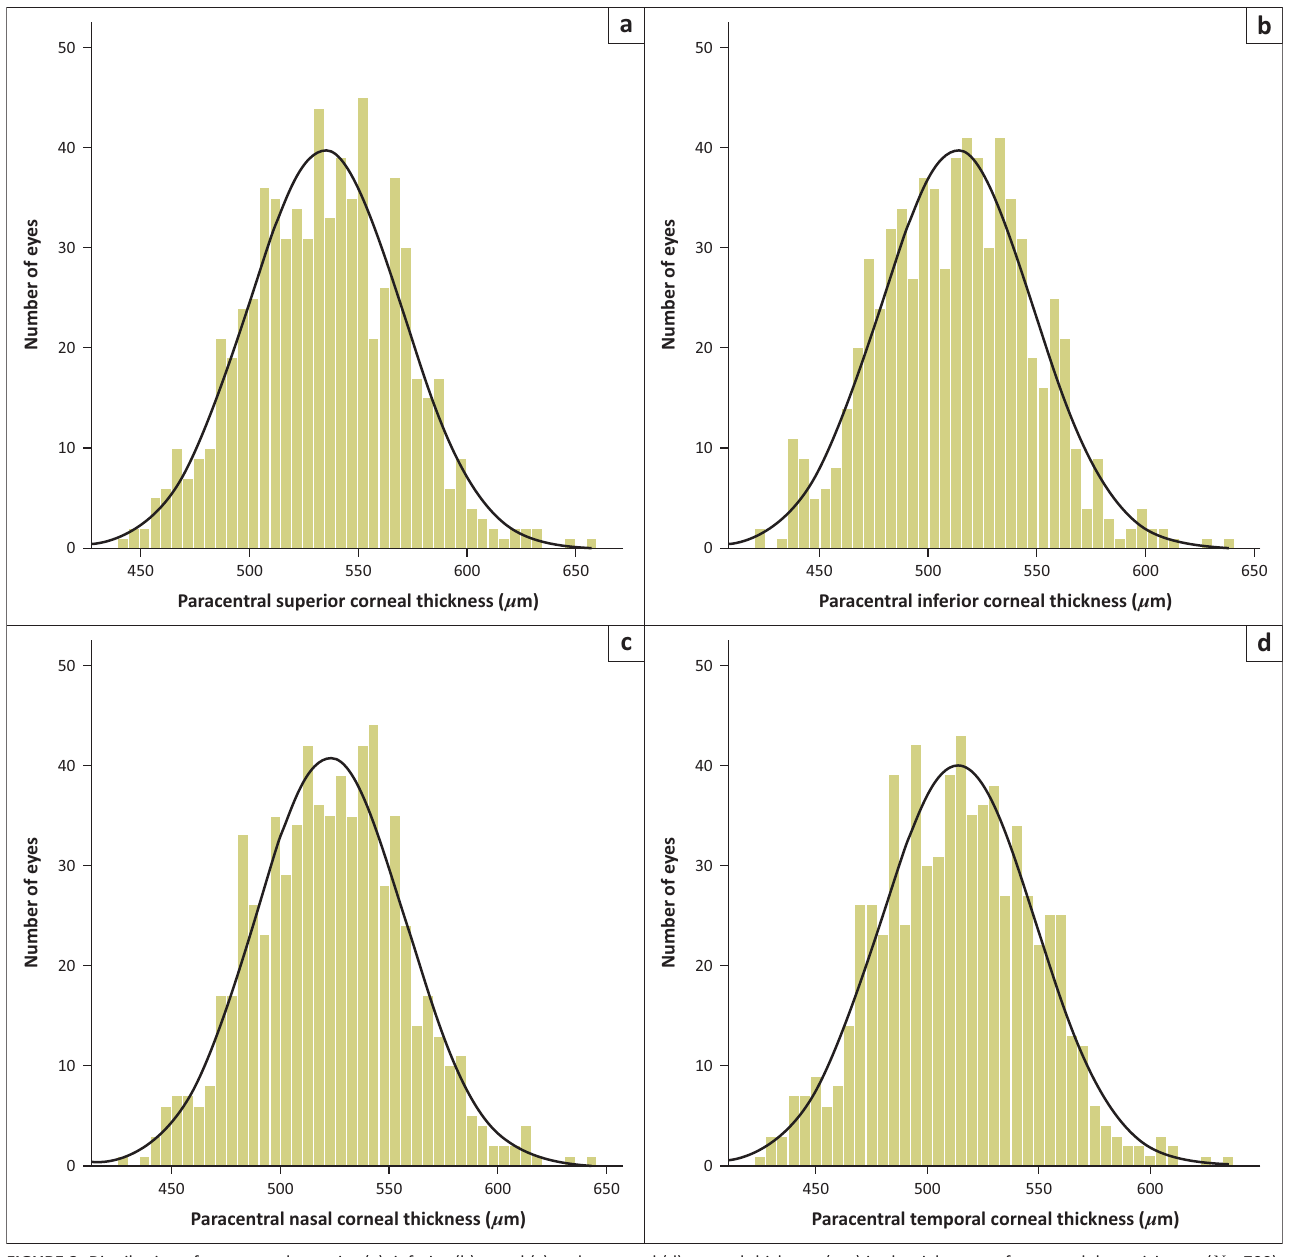
FIGURE 3: Distribution of paracentral superior (a), inferior (b), nasal (c) and temporal (d) corneal thickness ( µ m) in the right eyes of young adult participants ( N = 700), aged 17–30